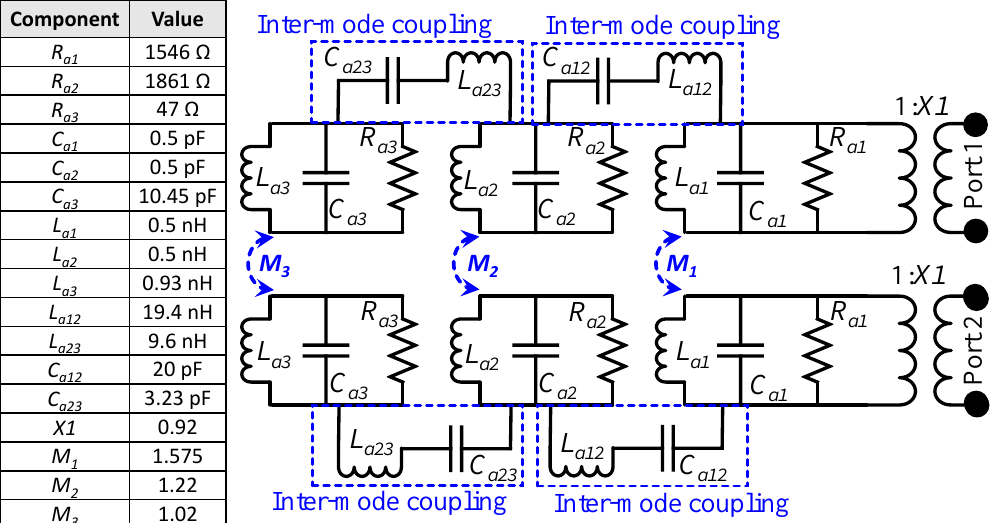
Figure 4. Lumped element equivalent circuit model of the UWB-MIMO system without decoupling structure.